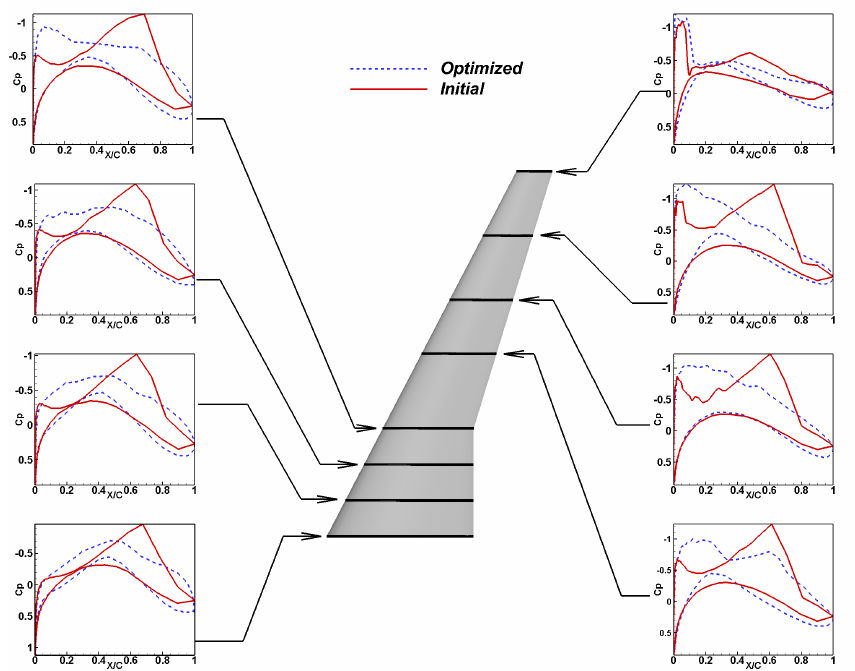
Figure 9. Comparison of surface pressure coefficient distributions for initial and optimized wings.